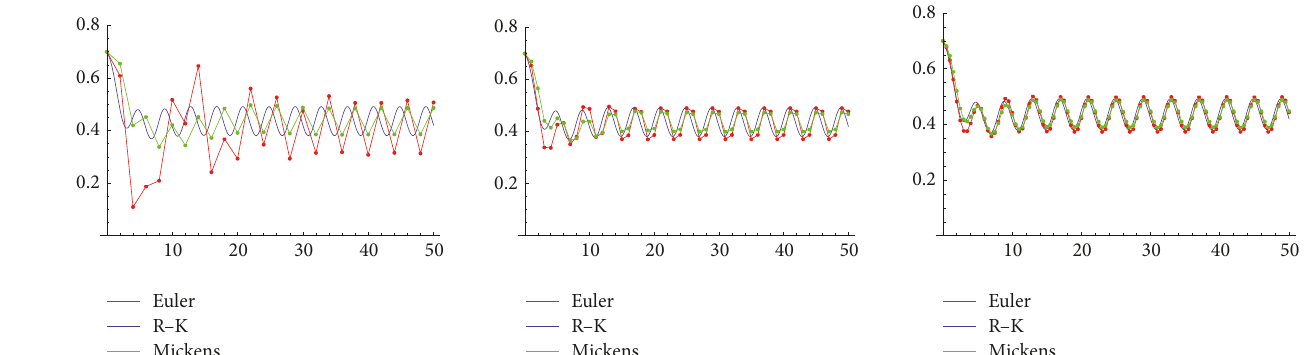
Figure 4: 𝑆𝐼 ; 𝜙(ℎ) = ℎ + 0.2ℎ 2 ; step-size: 2 , 1 , 0.5 .